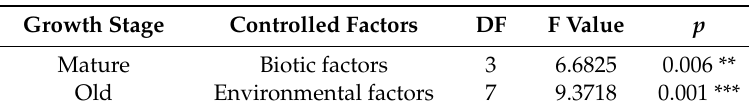
Table A4. Results of Redundancy Analysis of Mature trees controlled by biotic factors and old trees by environmental